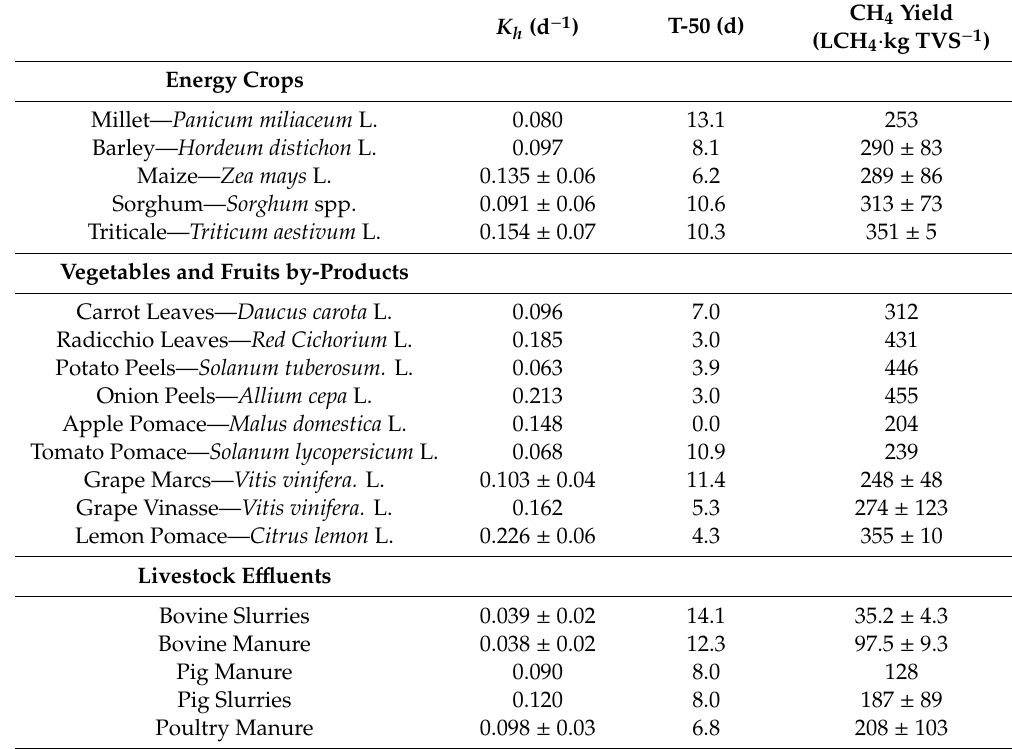
Table 4. K h , T-50 and methane yields of biomasses considered in this